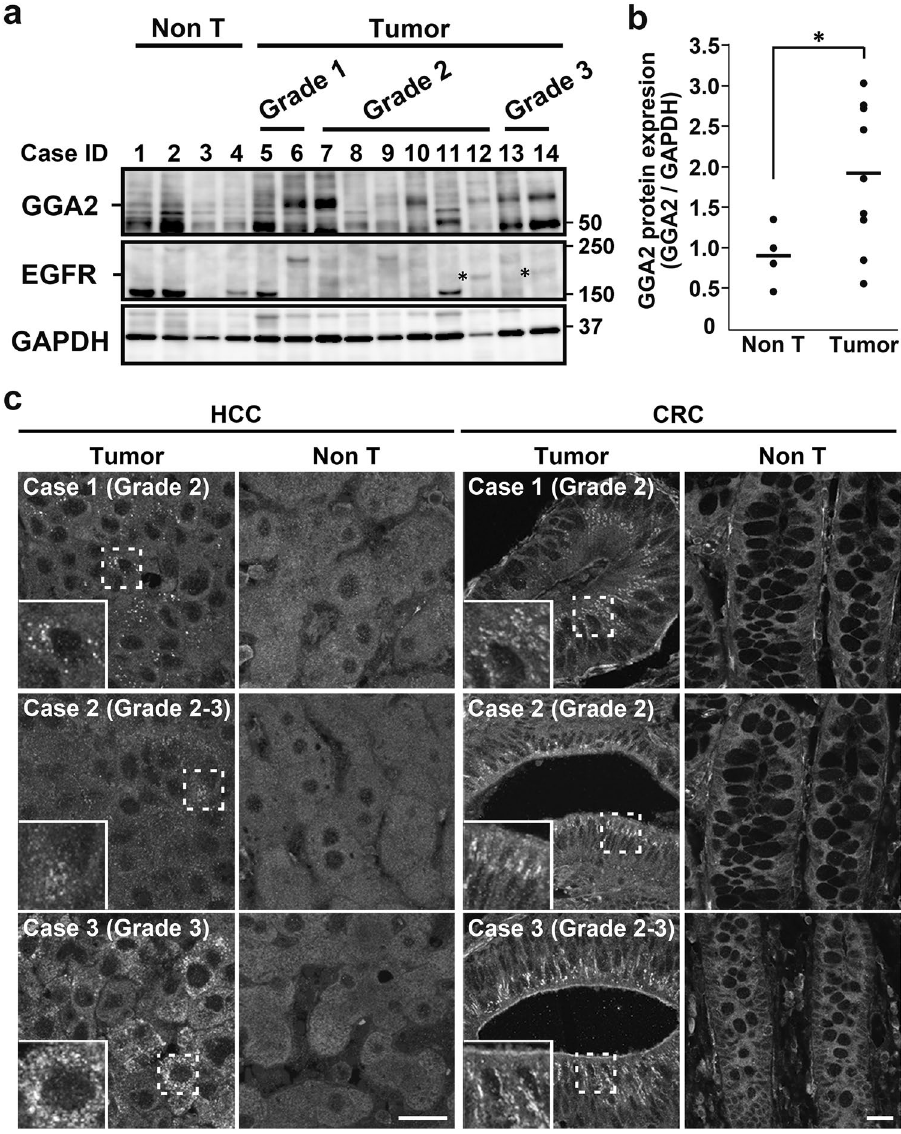
Figure 7. Expression of GGA2 in human hepatocellular carcinoma (HCC) and colorectal carcinomas (CRC). ( a ) Western blot analysis of GGA2 and EGFR expressions in non-tumor (Non T; 4 cases) and tumor regions of HCCs (10 cases). Asterisks indicate bands for EGFR. Histological grade is shown for each case (see Supplementary Table S1 for more detail). Uncropped blots are presented in Supplementary Fig. 7. ( b ) Ratios of GGA2 to GAPDH were calculated and normalized to that of case #1. Statistical analysis was performed using Mann-Whitney U -test; * P < 0.05. ( c ) Paraffin sections of tumors and adjacent non-tumor regions (Non T) from three cases of HCC and CRC were immunostained using anti-GGA2 antibody. Histological grade is shown for each case. Boxed regions are magnified and shown in insets; Bars, 20 μ